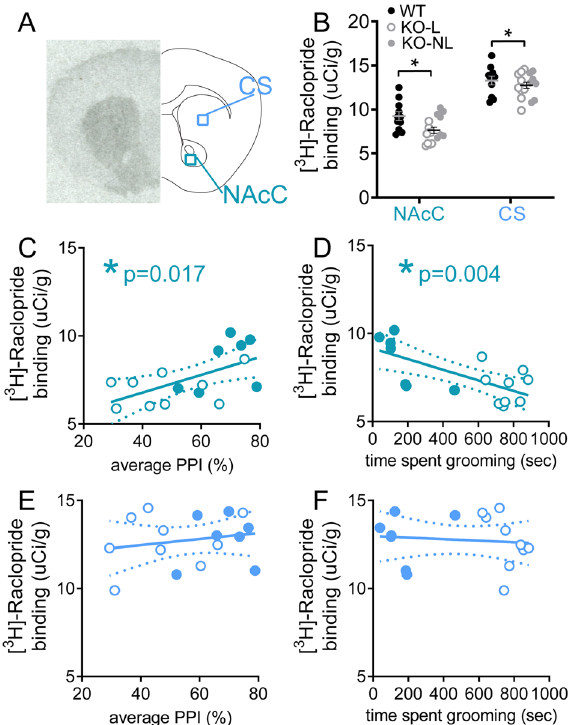
Figure 2. Reduced dopamine D2/3 receptor density in NAcC is associated with severity of OCD-relevant phenotypes in Sapap3-KO mice. ( A ) Autoradiography was performed in striatal tissue to quantify density of D2/3 receptors in NAcC and CS using [3H]-Raclopride. (Left) Representative autoradiograph for total binding. (Right) Schematic of coronal brain section with regions of interest used for analysis. ( B ) D2/3 was significantly reduced in Sapap3-KO. Reduced D2/3 binding in NAcC was associated with lower %PPI ( C ) and increased severity of compulsive grooming ( D ) in Sapap3-KOs. D2/3 density in CS showed no association with %PPI ( E ) or grooming ( F ) in Sapap3-KOs. In panel B, * indicates significant difference between WT and KOs (p < 0.05), in panels C-D * indicates significant correlation (p < 0.05). In panels B-F, unfilled KO symbol indicates KO-L, filled KO symbol indicates KO-NL. n = 11 WT, 16 KO. PPI prepulse inhibition, CS central striatum, NAcC Nucleus accumbens core, KO Sapap3 knockout, KO-L KOs with lesions, KO-NL KOs without lesions, WT